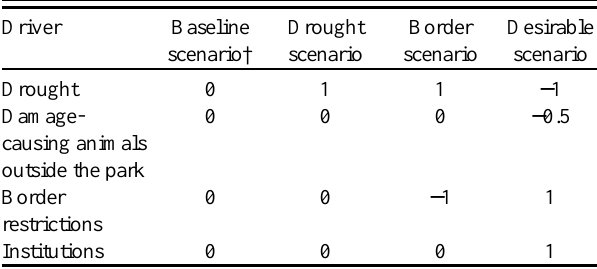
Table 3. Strength of the driver of livelihood functioning by scenario type as identified and described by local people and their stakeholders in southeastern Zimbabwe. 1 = very strong in relation to Baseline